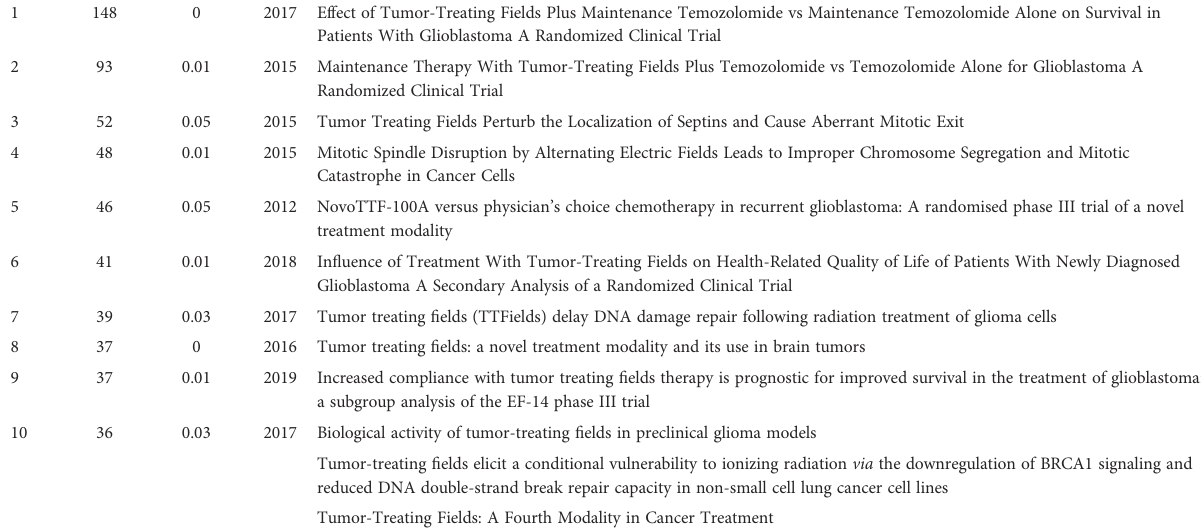
TABLE 4 Top 10 co-cited references of related publications. Rank Count Centrality